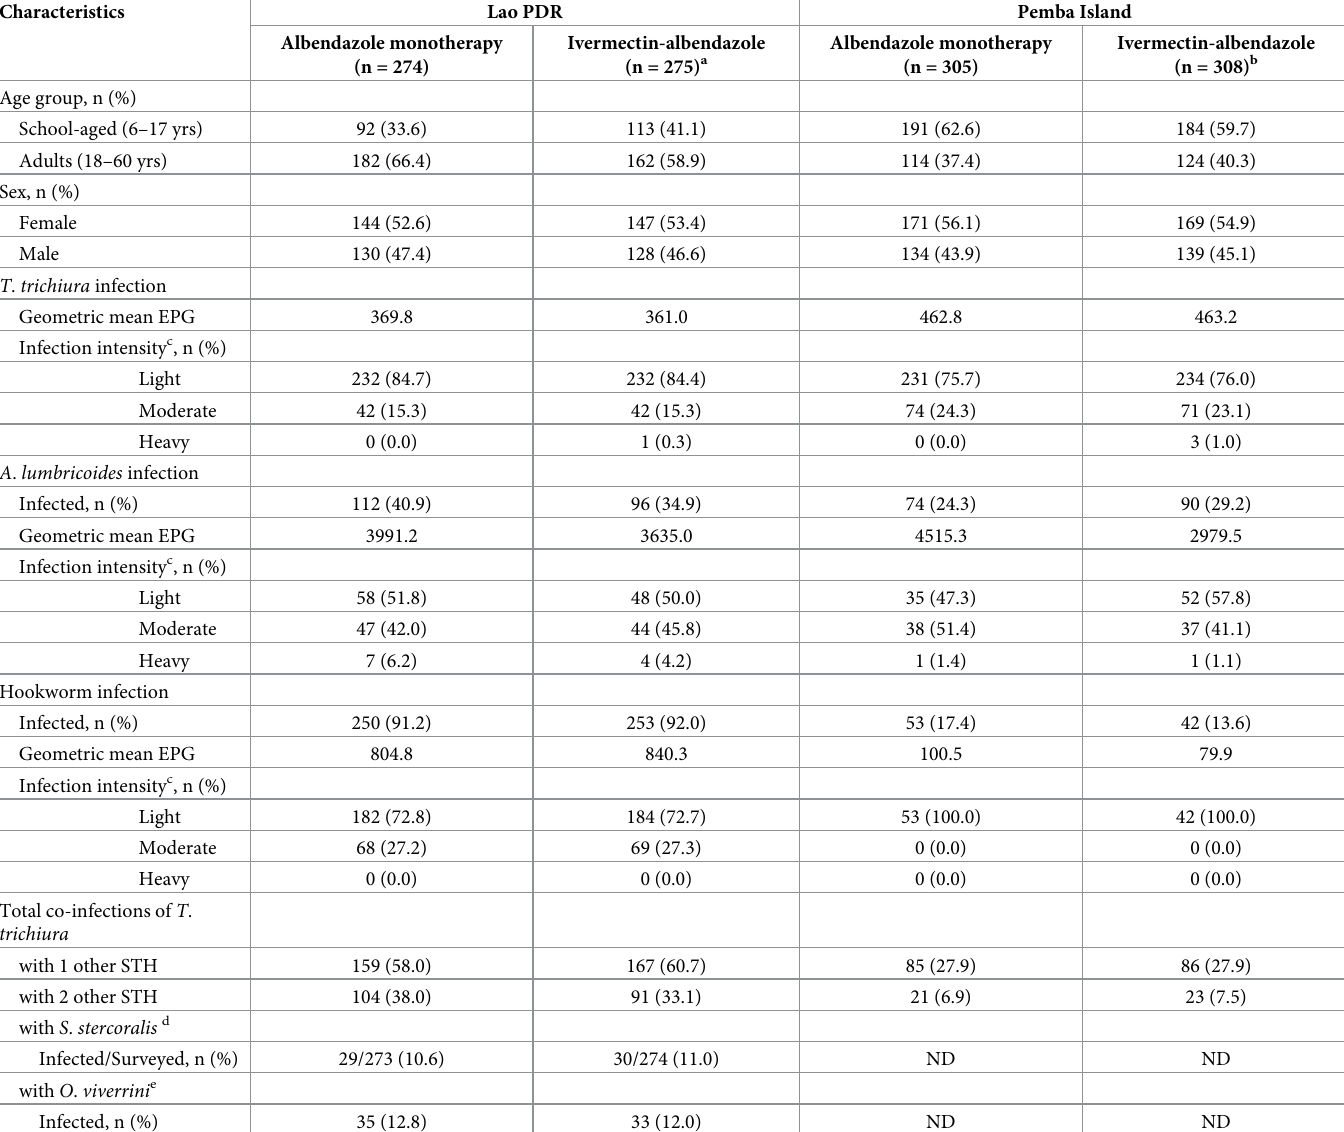
Table 1. Baseline characteristics of country trial